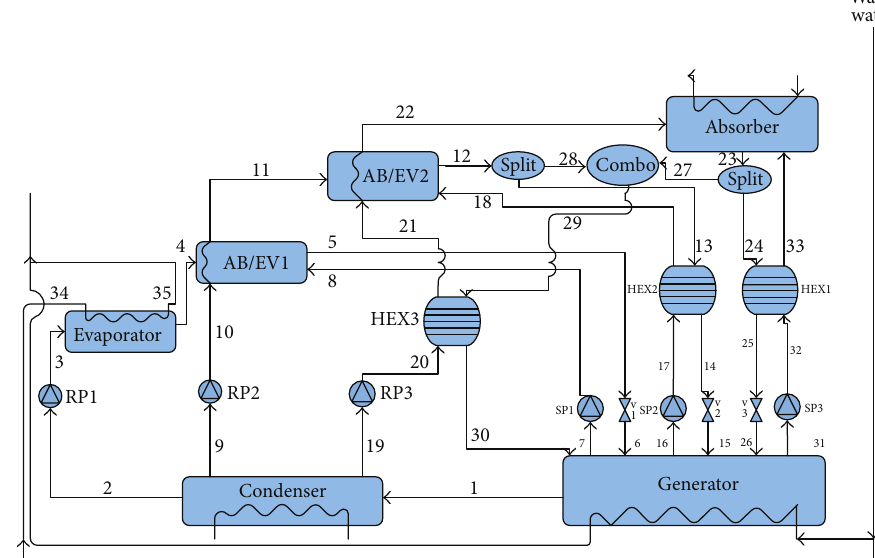
Figure 2: Schematic diagram of a triple absorption heat